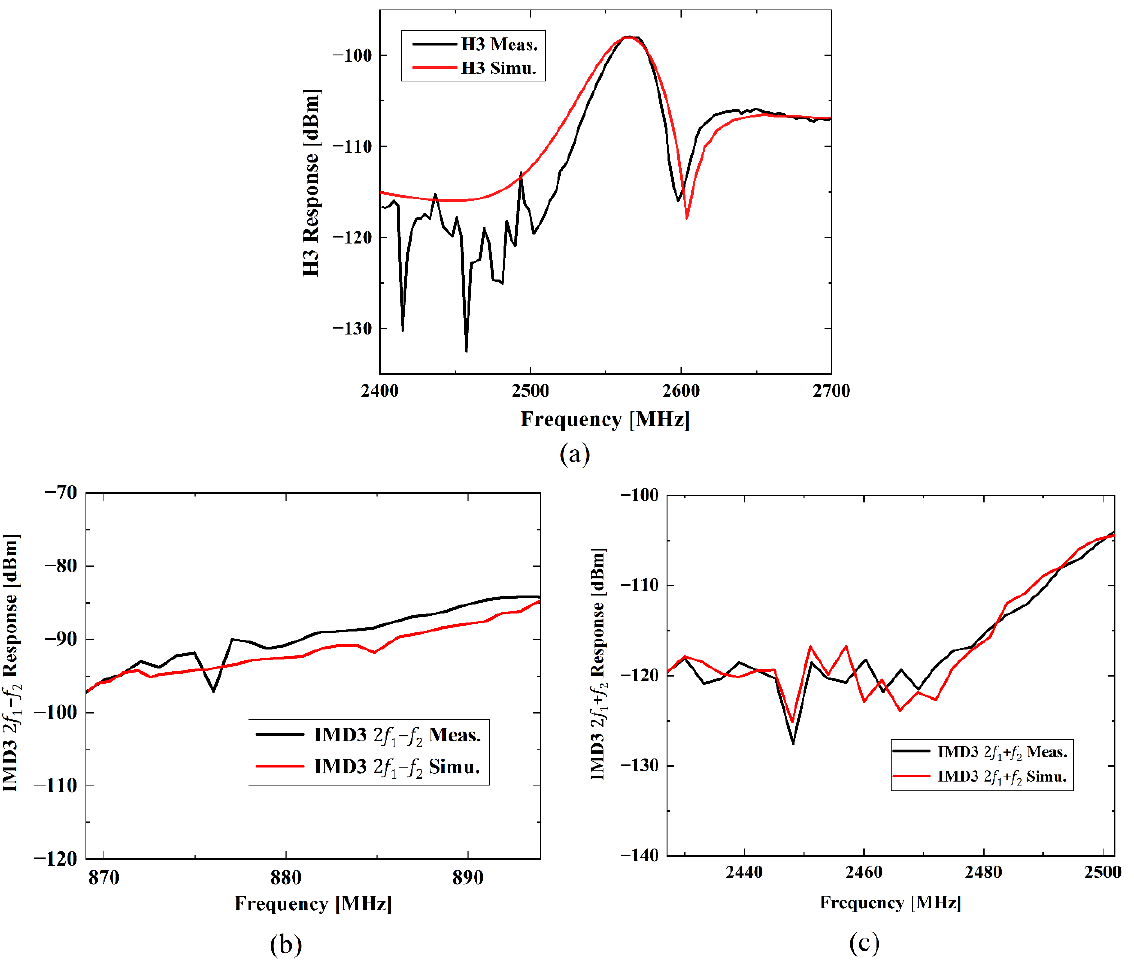
Figure 4. Measured [16] and simulated nonlinear responses of the SAW resonator: ( a ) H3 response, ( b ) IMD3 2 f 1 − f 2 response, ( c ) IMD3 2 f 1 + f 2 response.